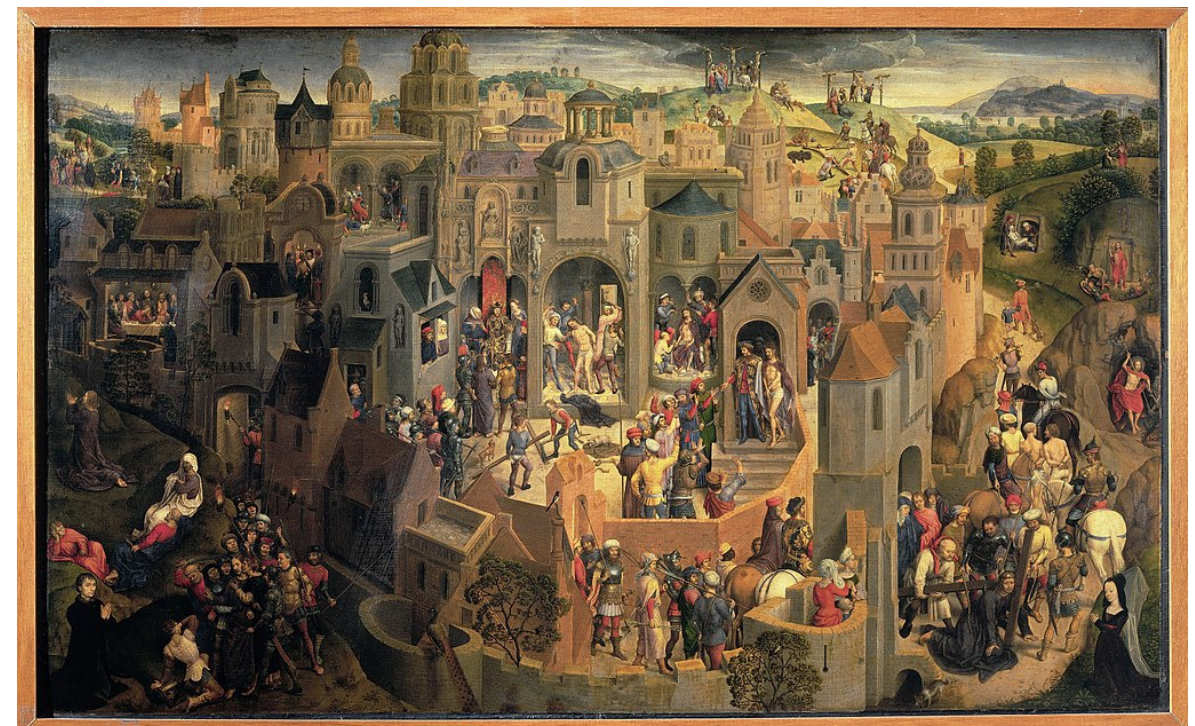
Figure 12. Hans Memling, Panorma with Passion of Jesus, ca. 1470/71 (Turin, Galleria